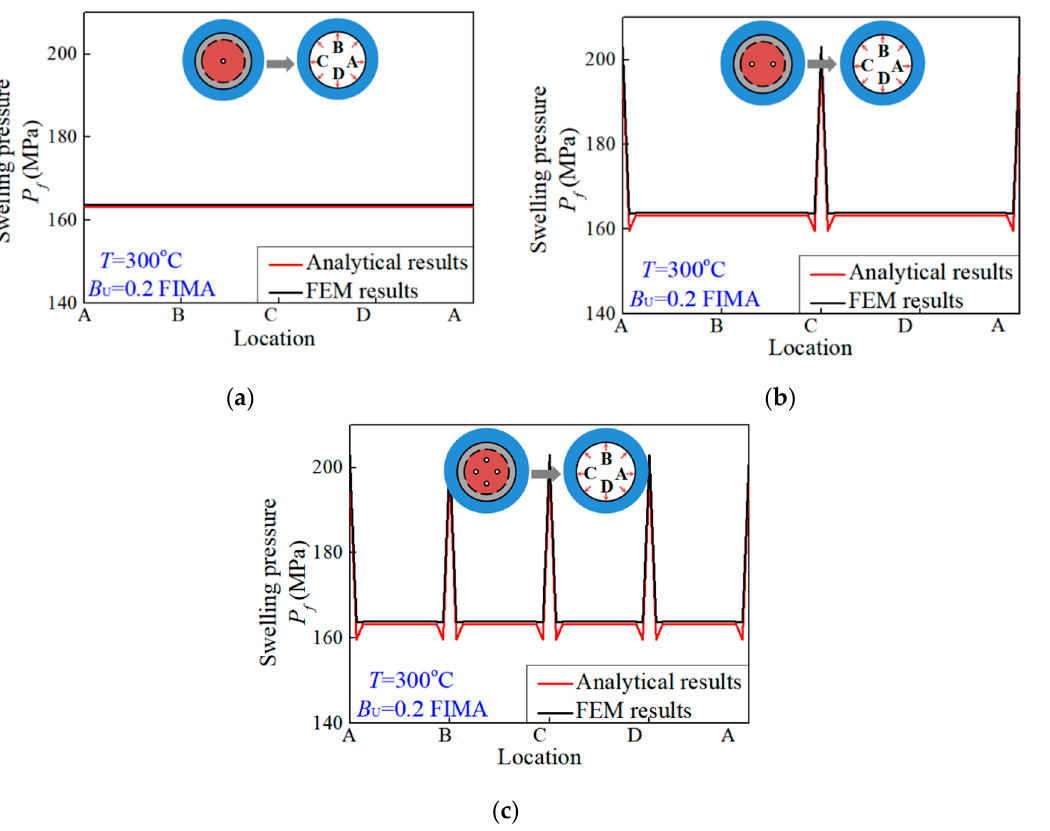
Figure 4. The distributions of irradiation swelling pressures exerted on the matrix interface Γ when there exists ( a ) one central fission pore, ( b ) two symmetric fission pores and ( c ) four symmetric fission pores.